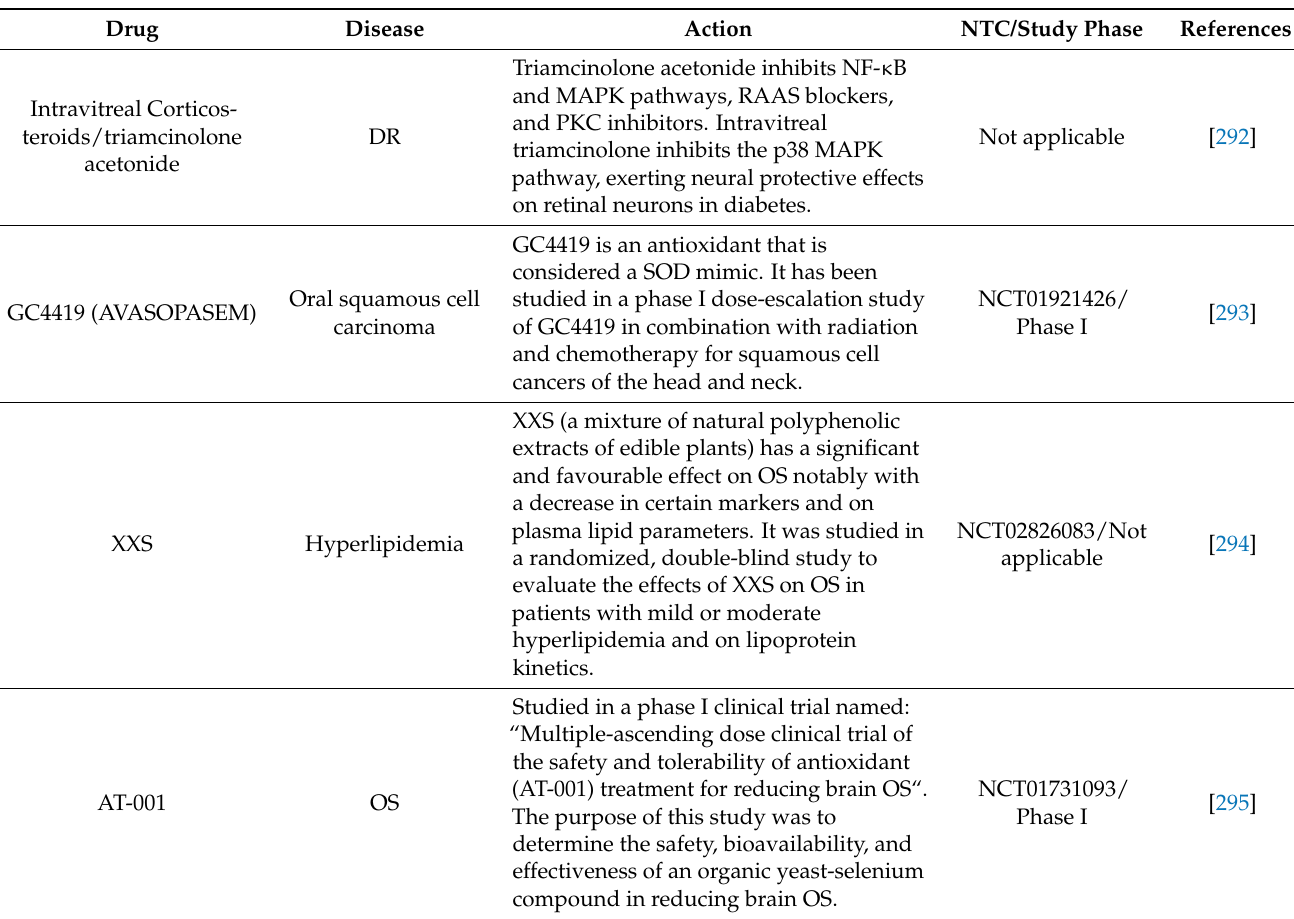
Table 2. Summary of the therapeutic strategies against oxidative stress (OS) and their use for certain diseases, including diabetes and its